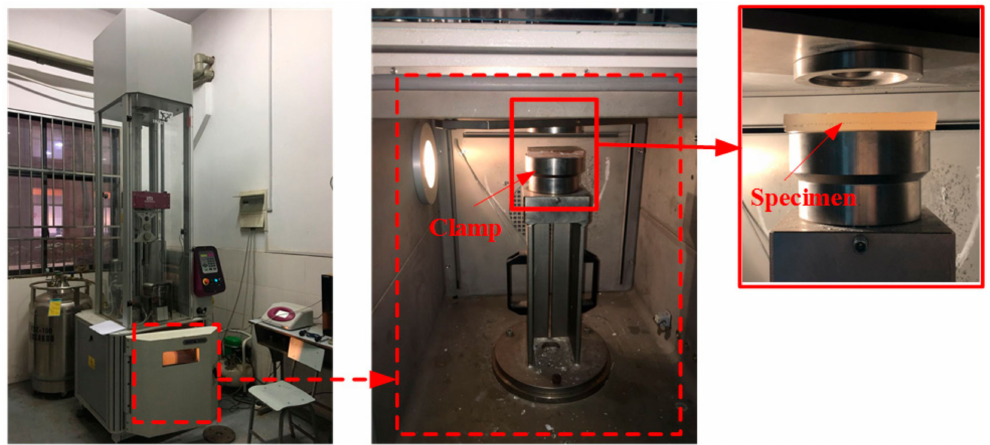
Figure 4. The Instron CEAST 9350HV drop weight impact testing